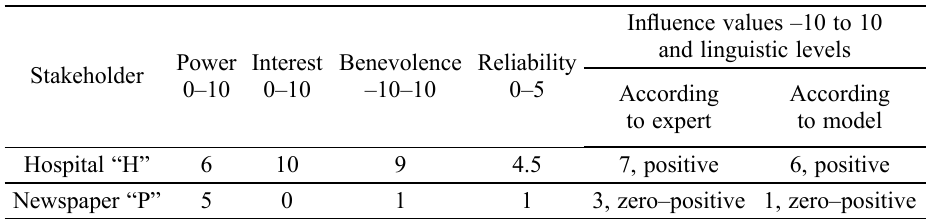
Table 3. Comparison of expert and fuzzy system‘s